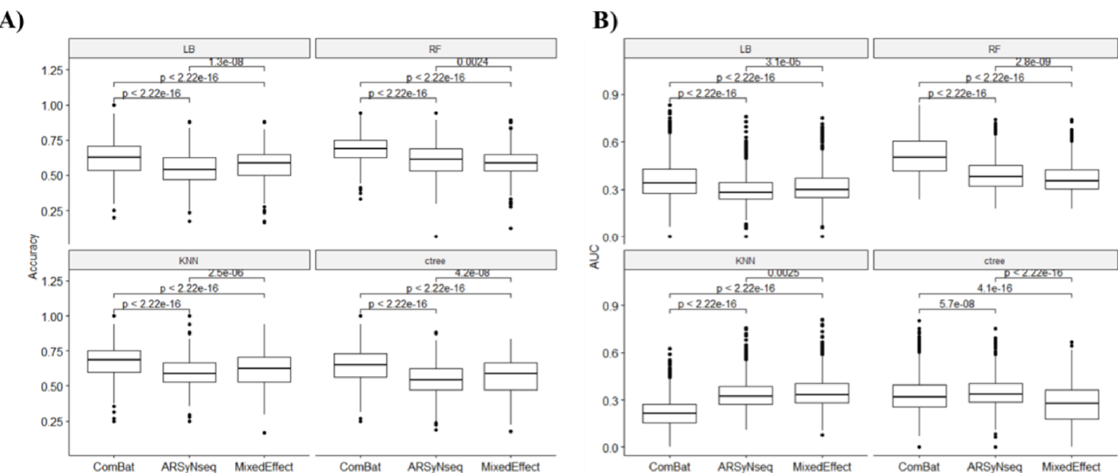
Figure 10. Comparison of each classifier (LB: LogitBoost, RF: Random Forest, KNN: k-nearest neighbors, ctree: decision tree) for each batch removal method used to classify patients with positive biopsies. ( A ) Boxplot of accuracy values. ( B ) Boxplot of AUC values.